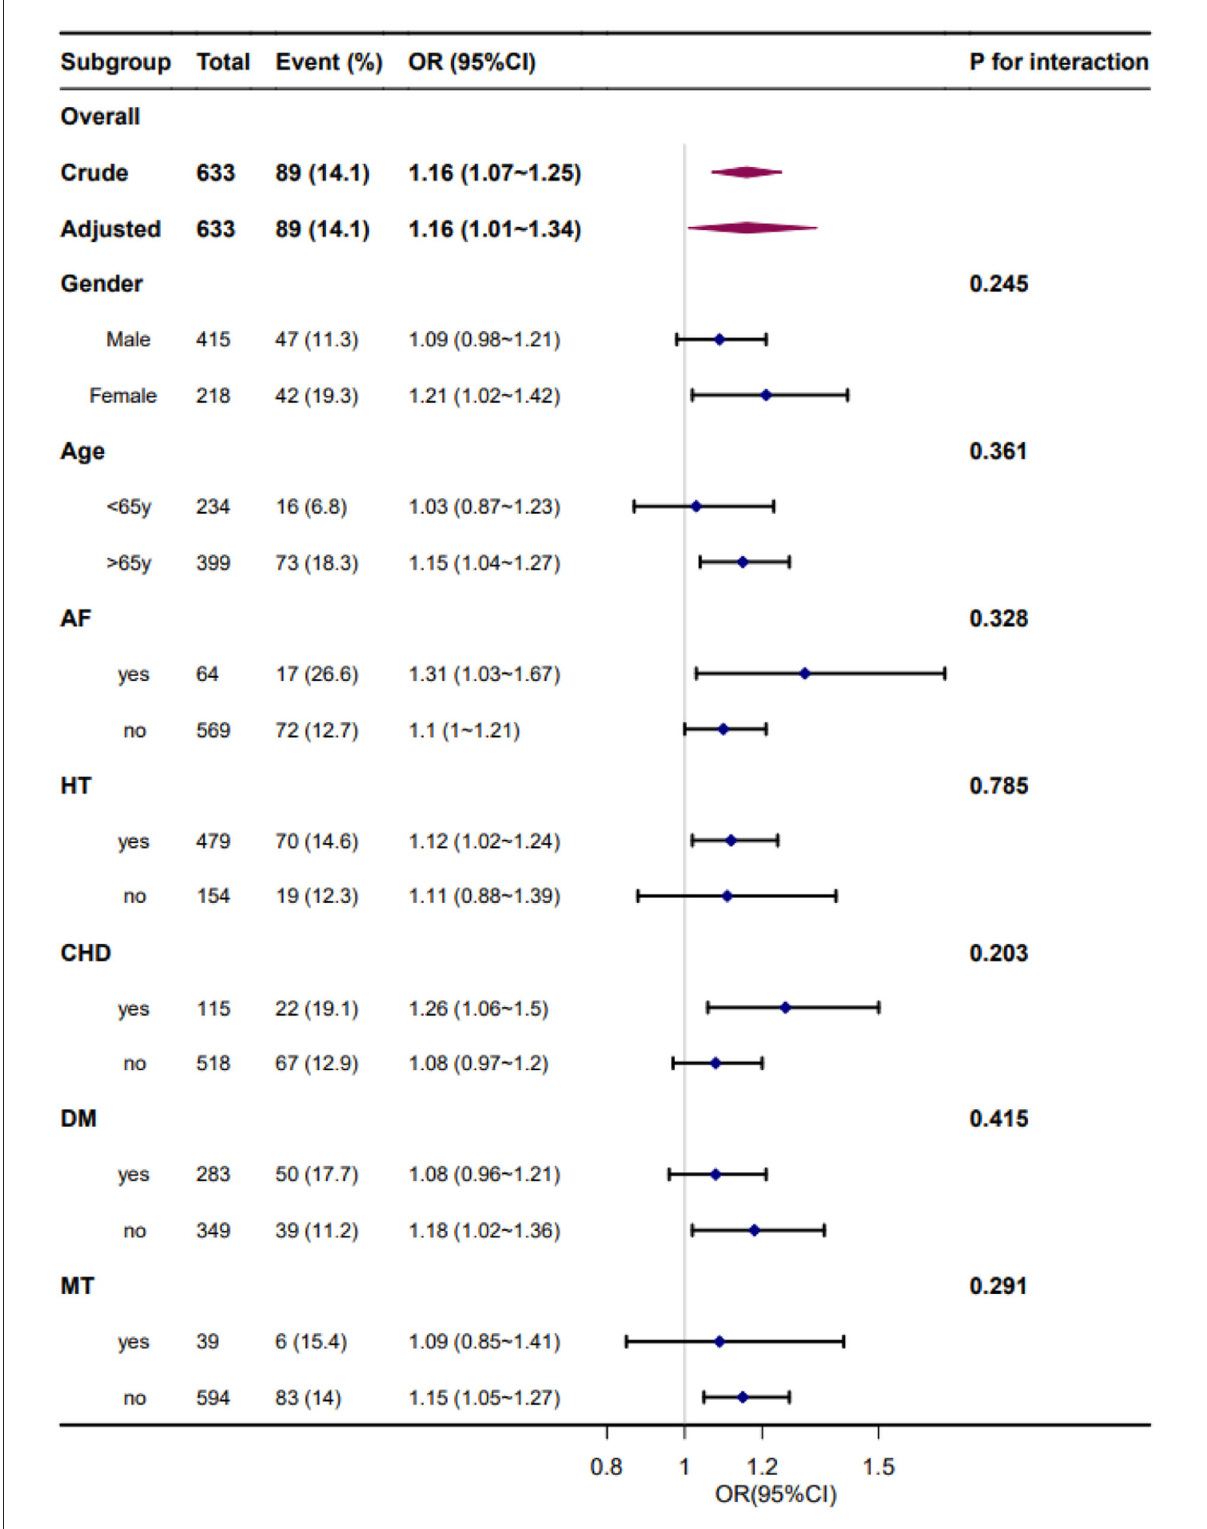
FIGURE5 Forest plot of the coefficient variation of systolic blood pressure and adverse outcomes by subgroups and interactions. Adjusted for age, sex, smoking, alcohol consumption, hypertension, fasting plasma glucose at enrollment, low-density lipoprotein, neutrophils, TOAST classification, NIHSS score at enrollment, early neurological deterioration, and mean blood pressure. AF, atrial fibrillation; HT, hypertension; CHD, coronary heart disease; DM, diabetes mellitus; MT, mechanical